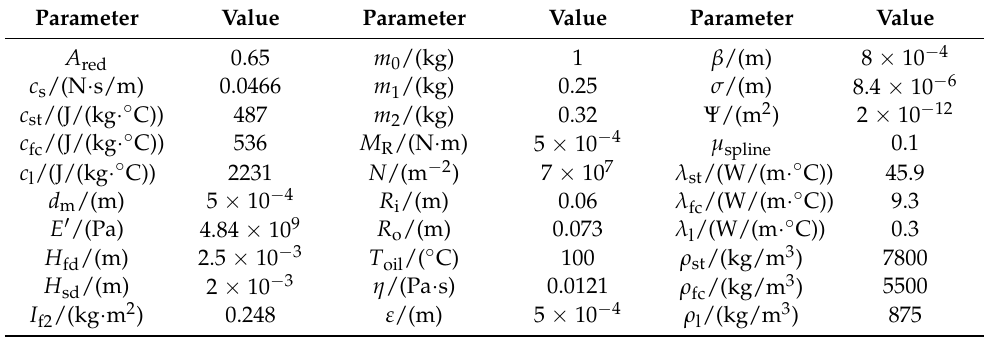
Table 1. Parameters of the simulation and test.